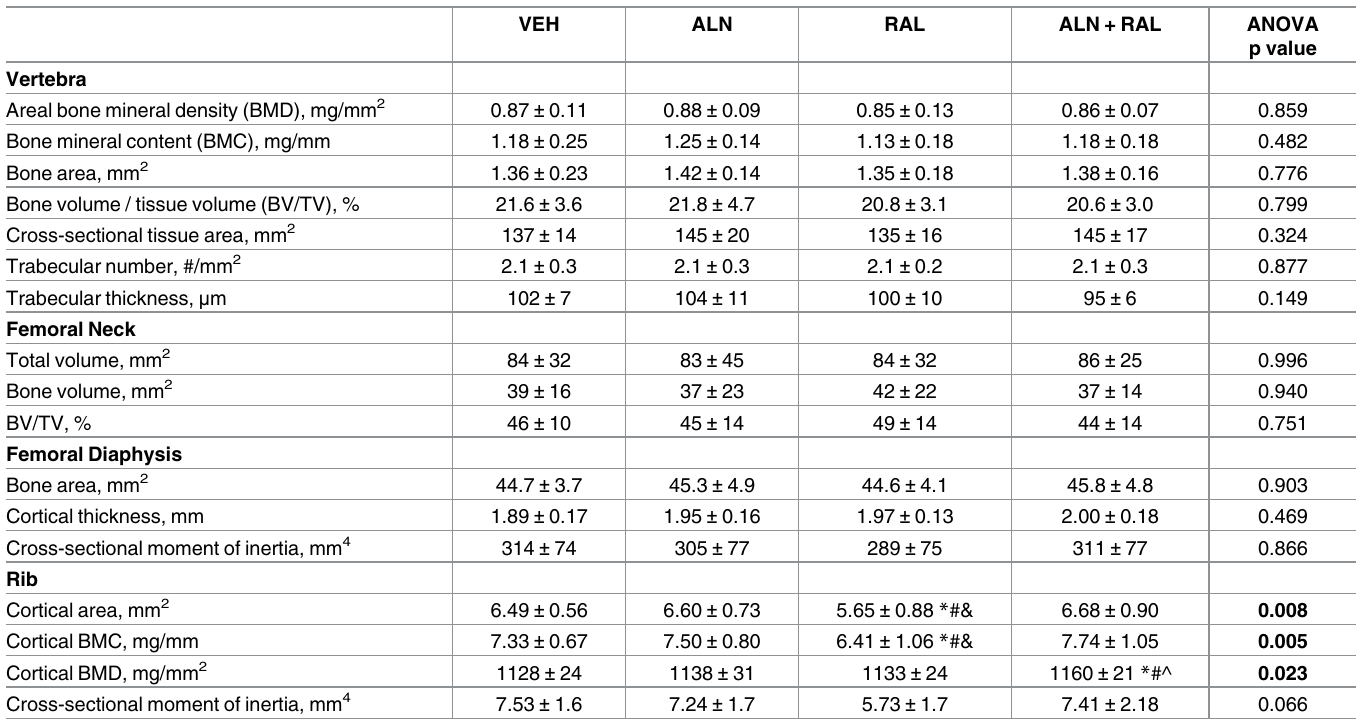
Table 4. Bone density, architecture and